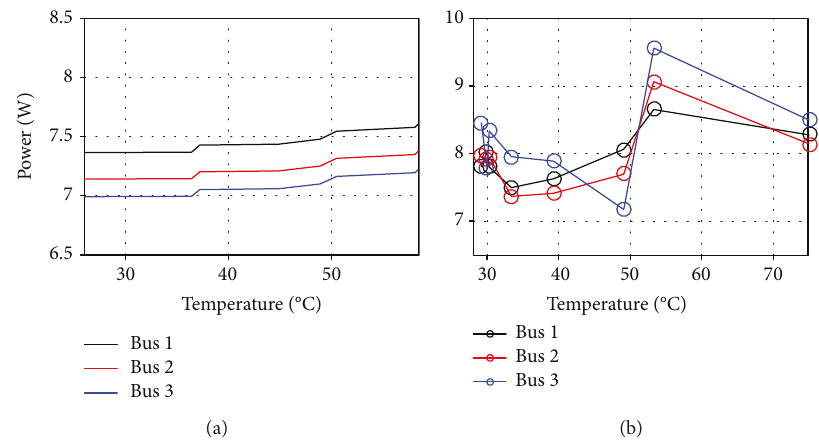
Figure 11: Power absorption at di ff erent temperatures for (a) single source and (b) multiple sources.